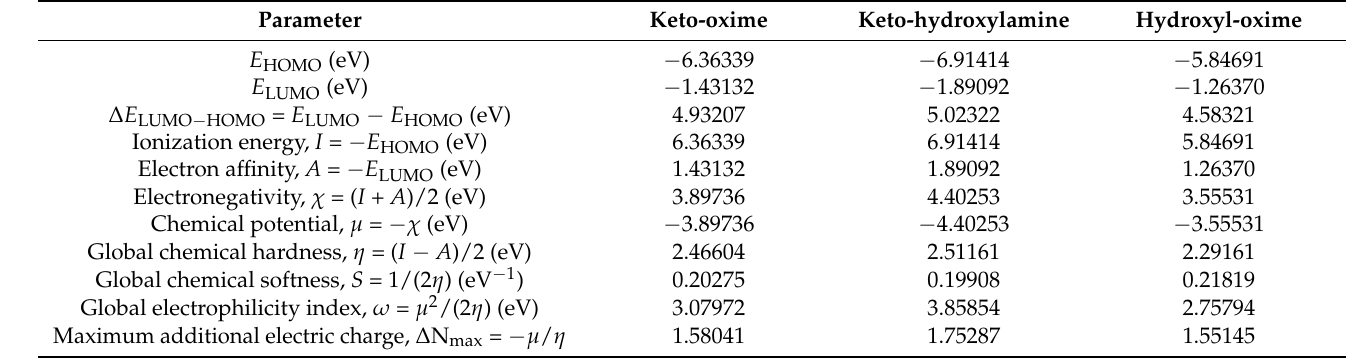
− 6.36339 ÷ − 5.84691 and − 1.89092 ÷ − 1.26370 eV, respectively, with the lowest and highest values corresponding to the keto-hydroxylamine and hydroxyl-oxime tautomers (Table 5). The corresponding energy gap varies from 4.58321 to 5.02322 eV (Table 5). Table 5. Frontier molecular HOMO and LUMO orbitals, gap value, and descriptors for the optimized structures of the keto-oxime, keto-hydroxylamine, and hydroxyl-oxime tautomers of molnupiravir, obtained by using the DFT/B3LYP/6-311++G(d,p) method. Parameter